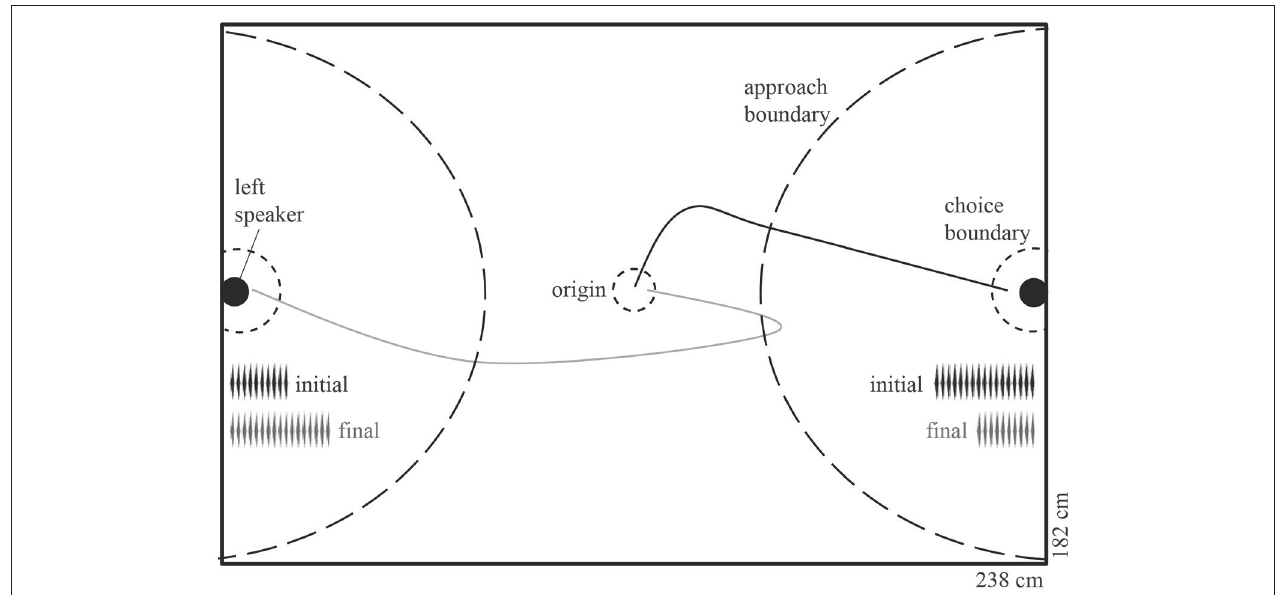
FIGURE 1 | Phonotaxis arena illustrating decision boundaries and an example trial with the pre-manipulation (initial) and post-manipulation (final) stimuli. The radii (from the center of the speaker) of the approach boundary was 80cm and the choice boundaries were 10cm. When a female crossed the approach boundary of the 18-pulse call, the stimuli were altered such that the initially approached speaker begins to broadcast the less attractive 10-pulse call and the opposing speaker broadcasts the 18-pulse call. A hypothetical non-reversal (solid black line) and reversal (solid gray line) phonotaxis path are shown. Internal length and width dimensions are